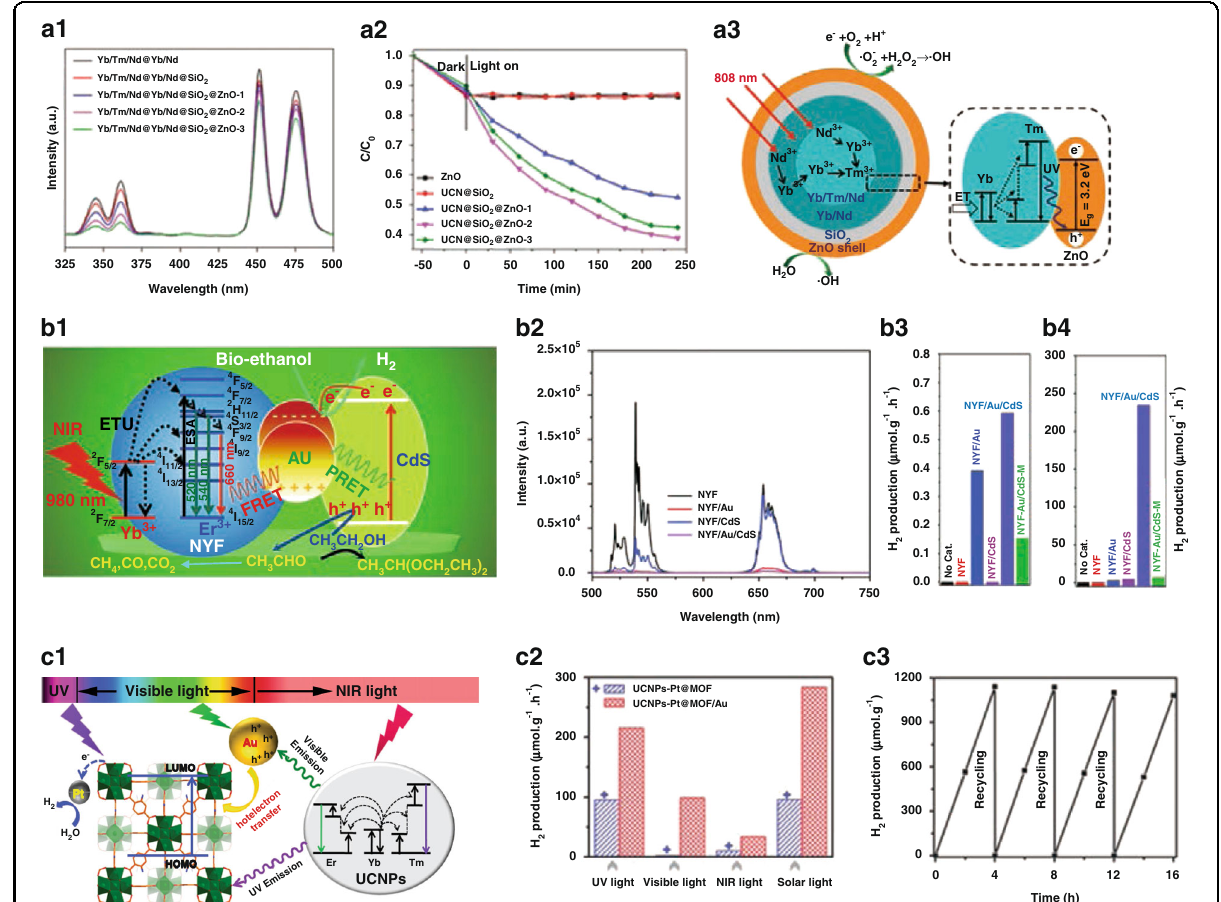
Fig. 11 Photocatalysis. a1 UCL spectra of different samples. a2 Time-dependent ratios of C / C 0 for Rhodamine B with different samples as photocatalysts. a3 ET process in UCNPs and the proposed photocatalytic mechanism for UCN@SiO 2 @ZnO 176 . b1 ET processes between NYF, Au, and CdS, and evolution process of bio-ethanol photoreformed H 2 under NIR irradiation. b2 UCL spectra of NYF, NYF/Au, NYF/CdS and NYF/Au/CdS. Photocatalytic H 2 evolution rates of different samples under NIR ( b3 ) and simulated sunlight ( b4 ) 179 . c1 Schematic diagram of photocatalytic H 2 production mechanism of UCNPs-Pt@MOF/Au. c2 H 2 production rates of UCNPs-Pt@MOF and UCNPs-Pt@MOF/Au under excitation by UV, Vis, NIR, and solar light. c3 Recycling test for H 2 production of UCNPs-Pt@MOF/Au under simulated solar light 164 . a1 – a3 Reprinted with permission